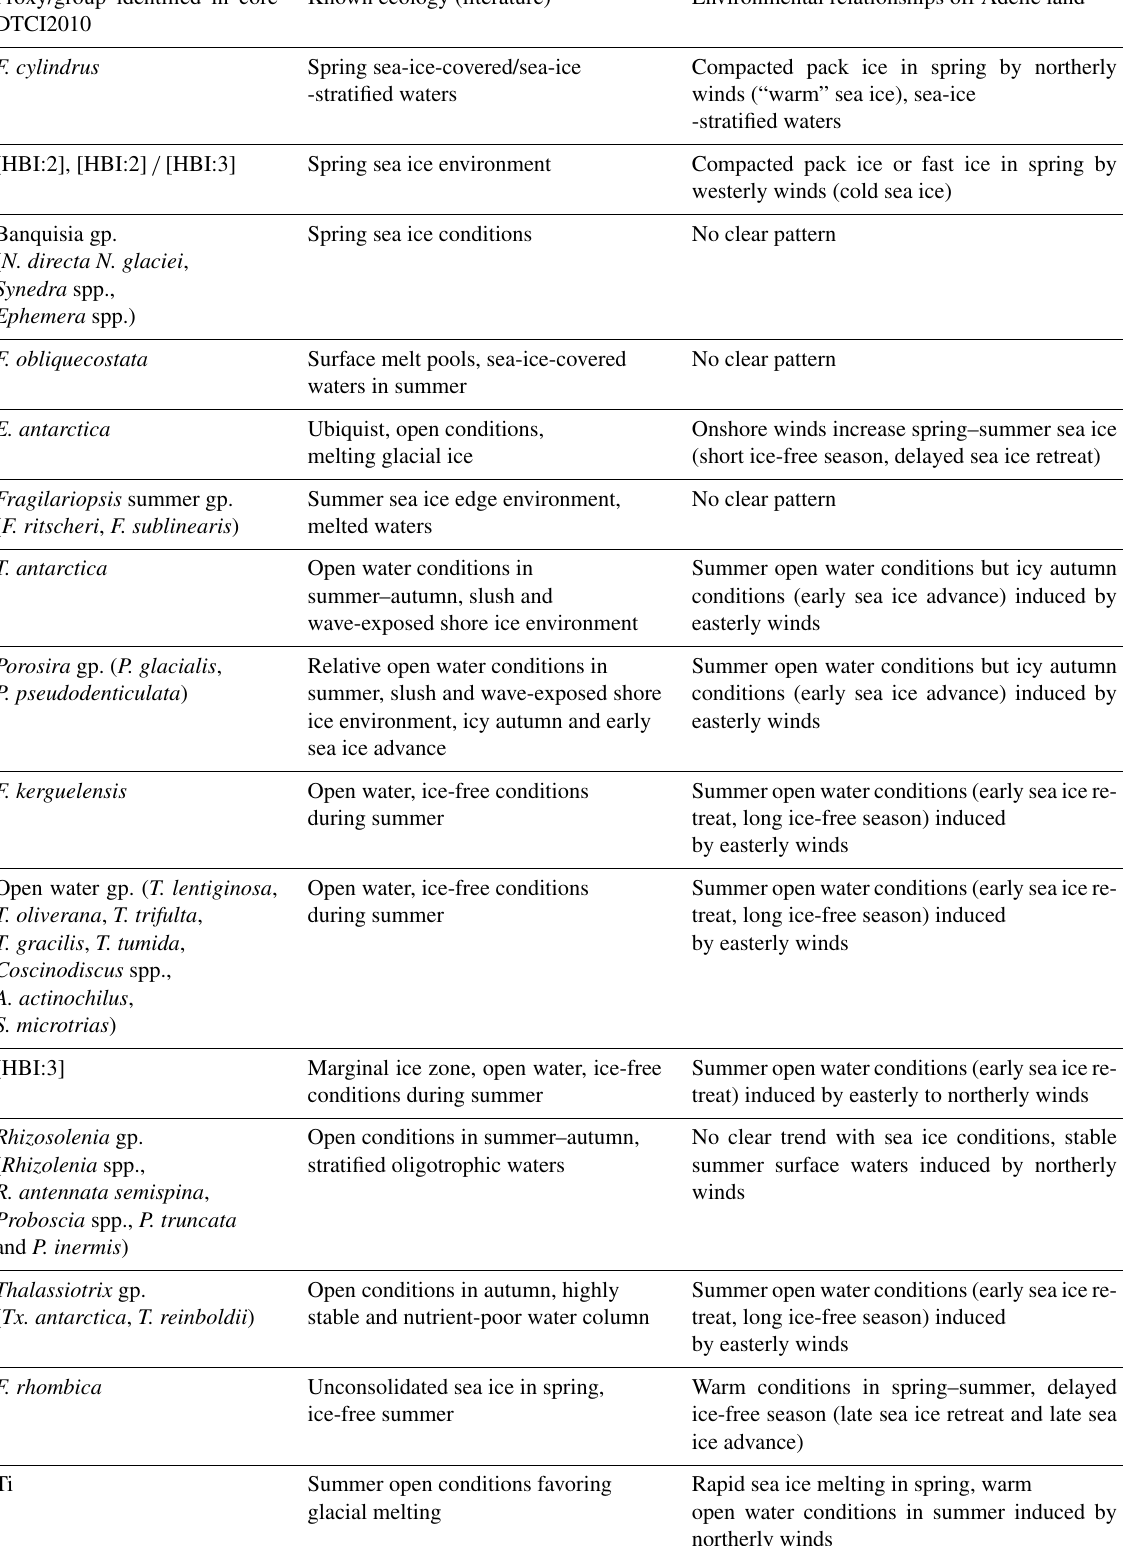
Table 1. Summary of the relationships between sedimentary proxies and environmental conditions. Proxy/group identified in